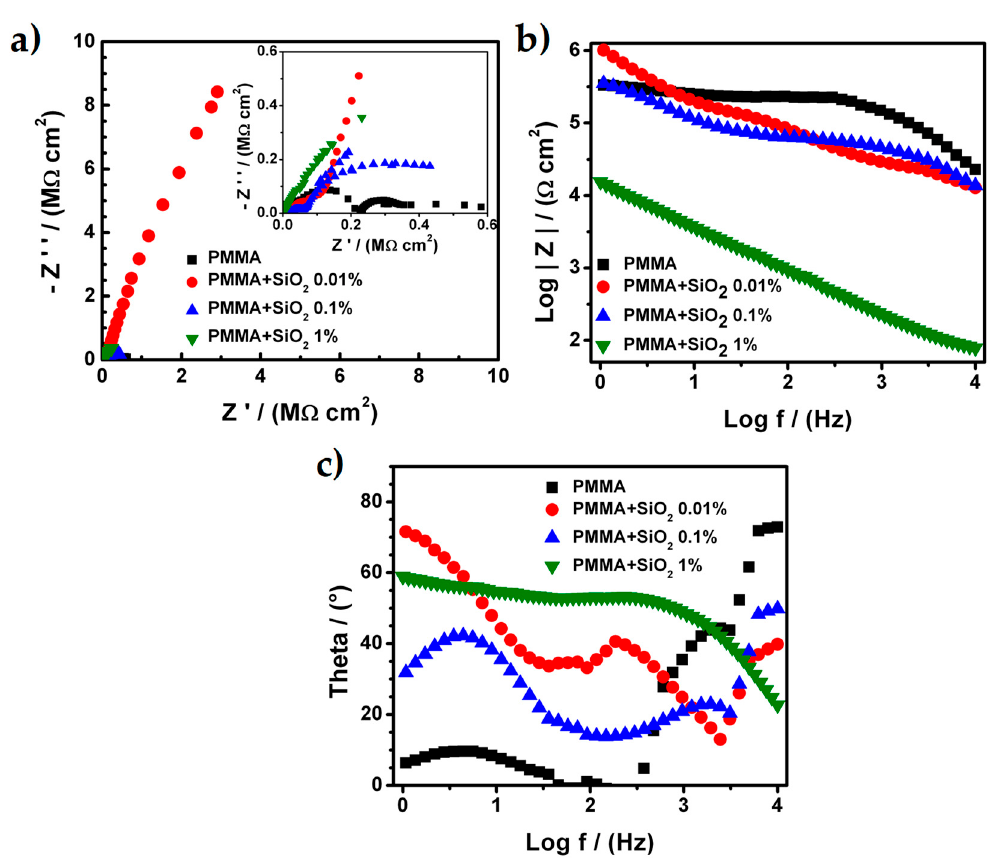
Figure 5. ( a ) Nyquist diagrams, ( b ) Bode diagrams and ( c ) phase-angle diagrams for the PMMA and PMMA + SiO 2 coatings with an artificial defect on the